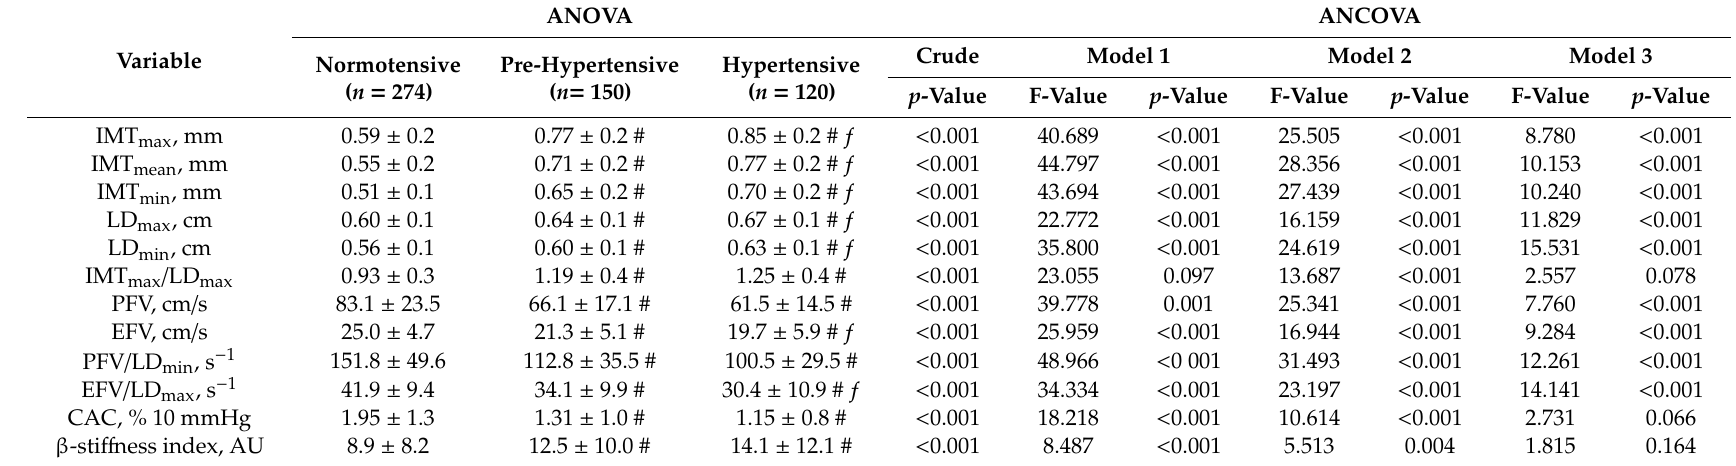
Table 3. Di ff erences in carotid arterial characteristics among groups according to the blood pressure category after multivariate adjustment.